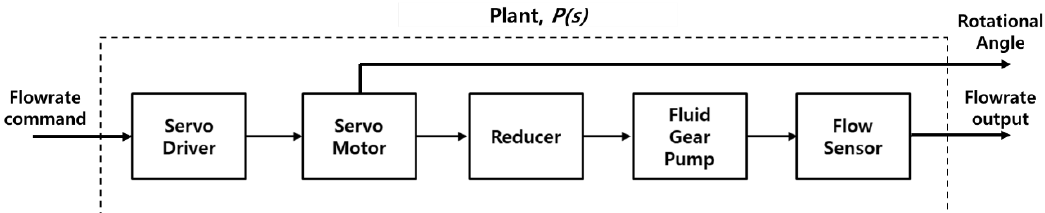
Figure 3. Block diagram of the fluid gear pump-based painting system.